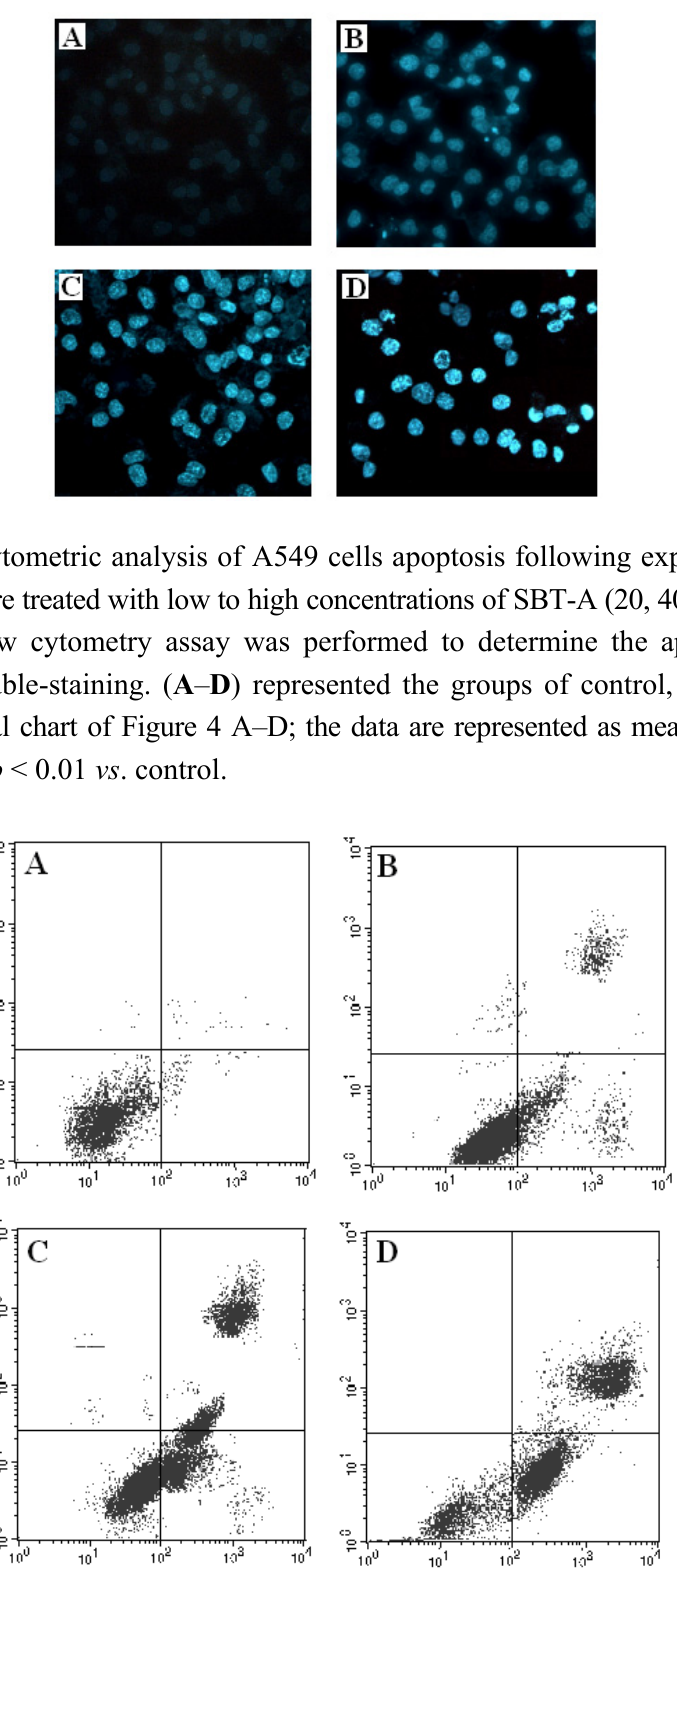
Figure 3. Fluorescence photomicrographs showing the effects of SBT-A on morphological changes of A549 cells by staining with Hoechst 33258 (×200). A549 cell lines were treated with low to high concentrations of SBT-A (20, 40, and 80 μ g/mL) for 48 h. ( A – D ) represent the control, 20, 40, and 80 μ g/mL groups.